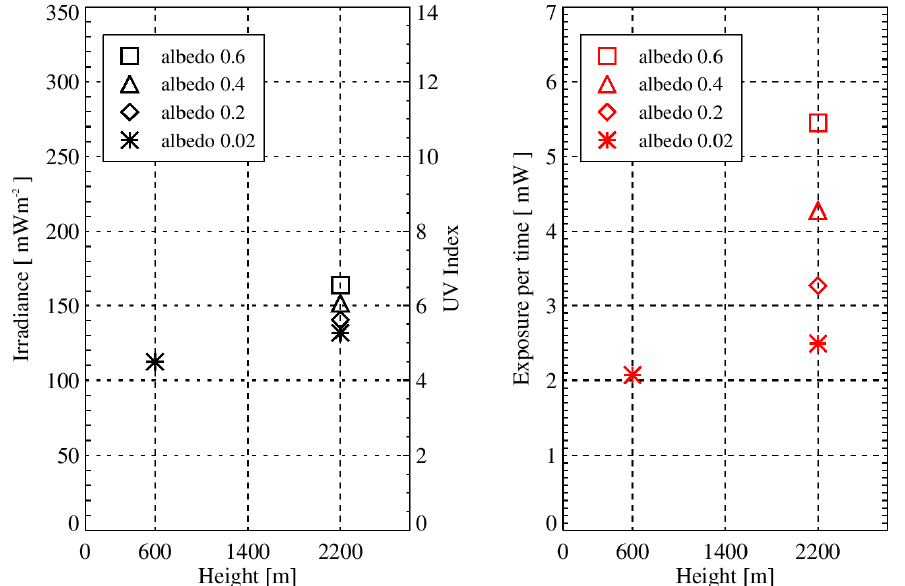
Figure 2. Simulated values of the irradiance ( left plot ) and the exposure of a human with winter clothing ( right plot ) for the valley and mountain locations are shown. The simulations were performed for a hypothetical location at 47 ◦ N for 31 March 2016 with a solar zenith angle (SZA) of 45 ◦ . The influence of the albedo is larger for the exposure (integrated radiance on a human) than for the